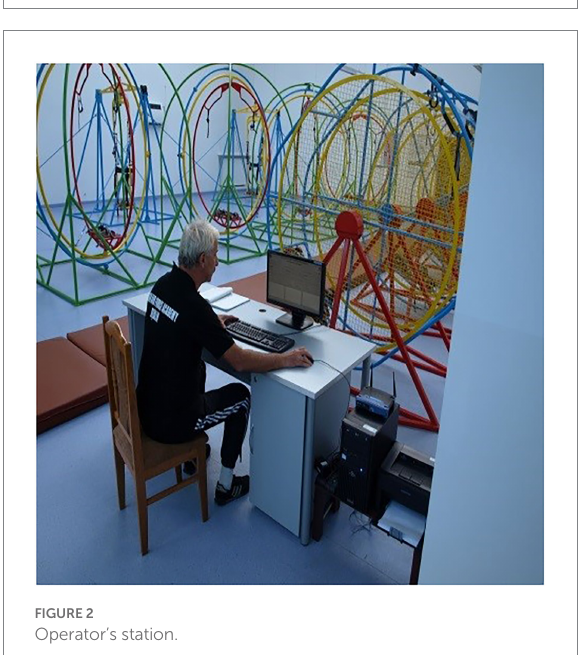
FIGURE 1 The test person with diagnostic and training device.